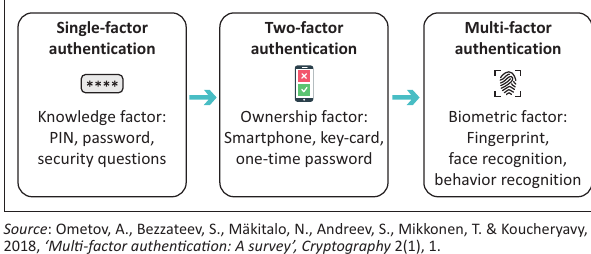
FIGURE 1: Evolution of authentication methods from single-factor authentication to multi-factor